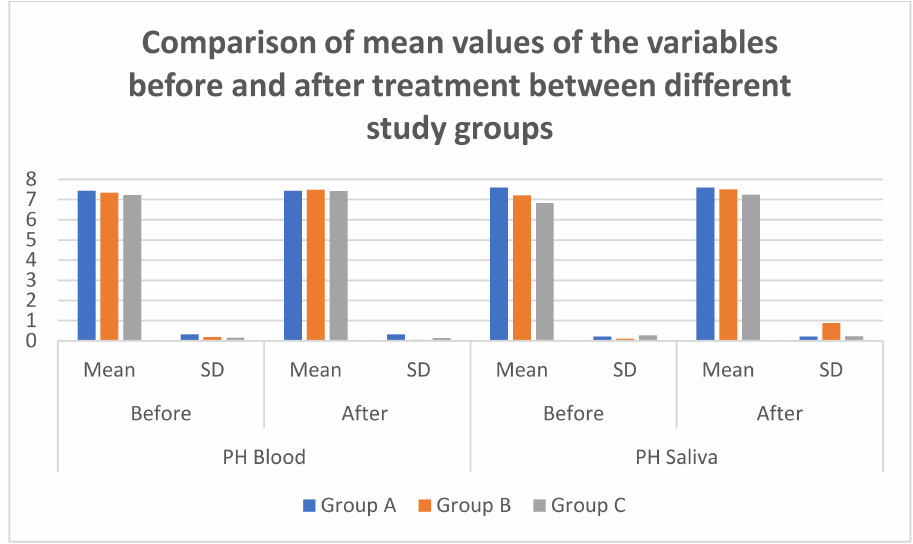
Figure 3. Comparison of mean values of the variables before and after treatment between different study